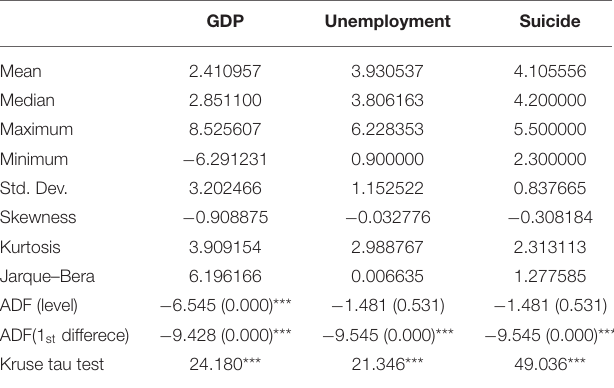
TABLE 1 | Summary statistics and unit root